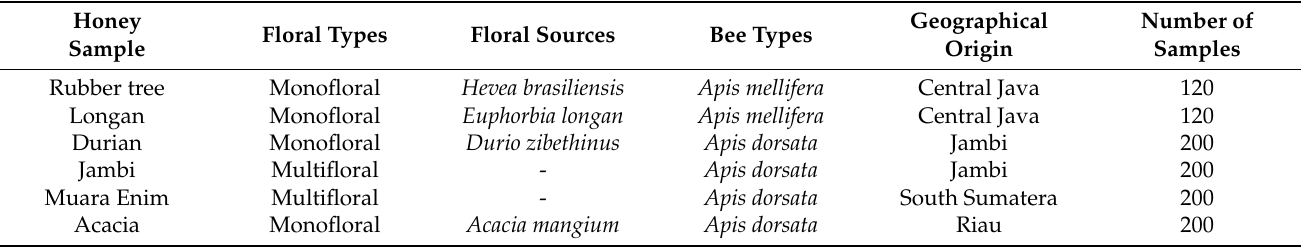
Table 1. The characteristics of the honey samples and their